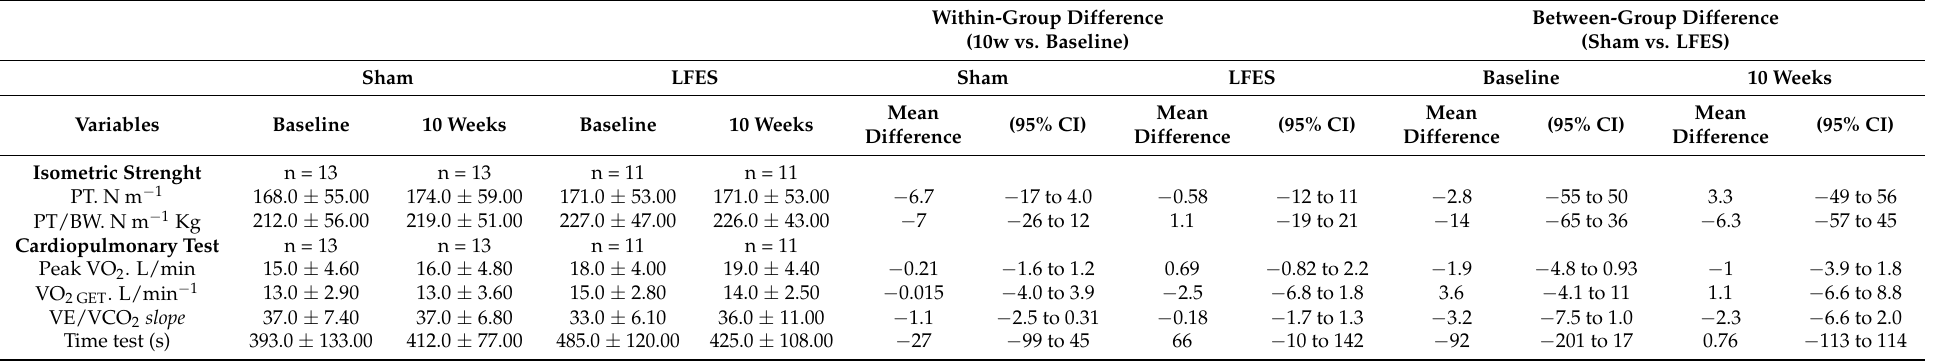
Table 3. Plasma cytokines profile and redox biomarkers following LFES intervention. Within-Group Difference Between-Group Difference (10w vs.